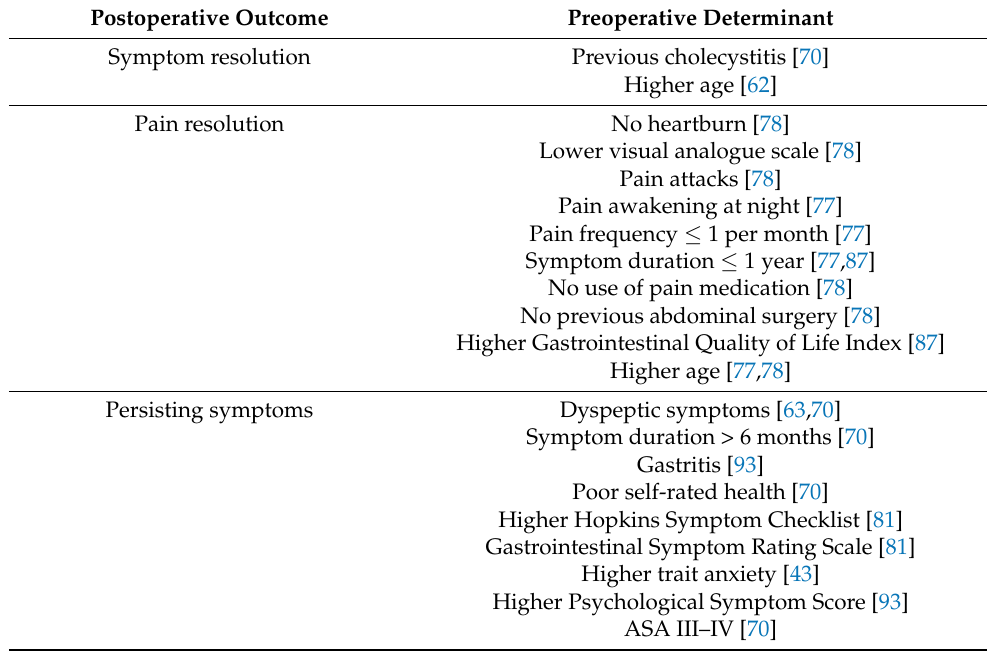
Table 2. Determinants of postoperative symptoms identified in prospective clinical